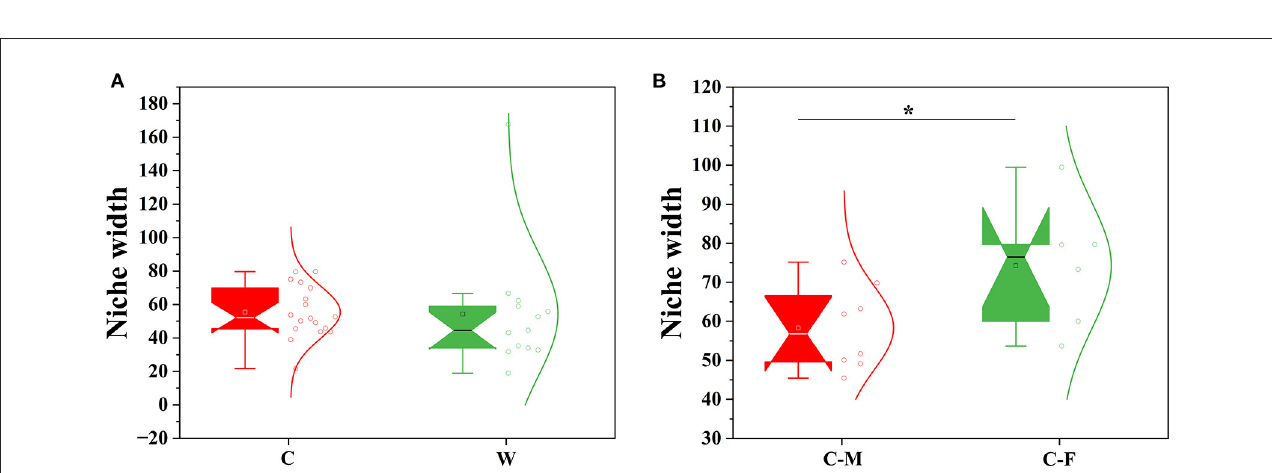
FIGURE3 Comparison of mean habitat niche width for all groups. (A) Wild vs. captive groups. (B) Captive female vs. captive male groups (W: wild, C: captive, C-F: captive female, and C-M: captive male; Significance * p <